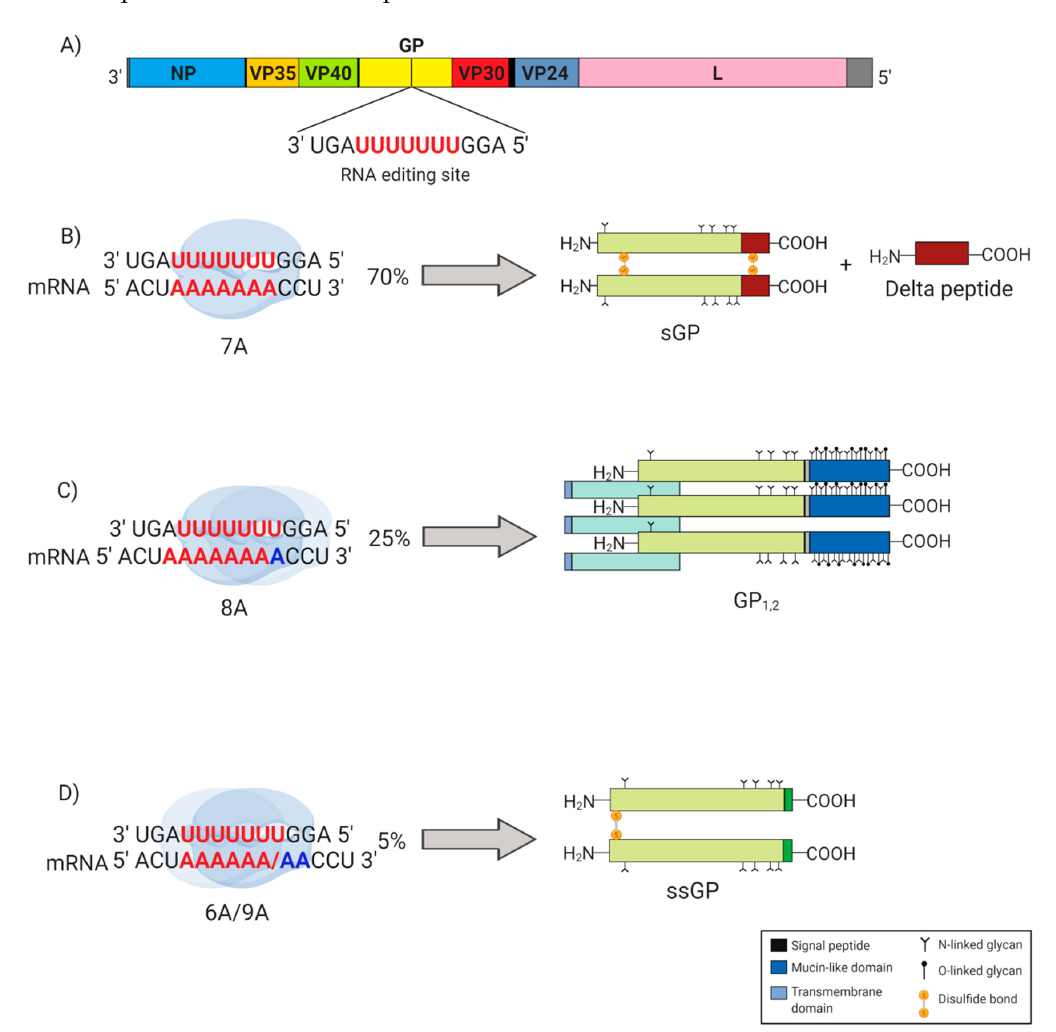
Figure 1. Glycoprotein (GP) gene editing in Ebola virus (EBOV). Highlighted (in red) in the EBOV GP gene are seven consecutive uridine (U) residues that act as the transcriptional editing site. ( A ) The EBOV genome encodes seven structural proteins, including the nucleoprotein (NP), virion